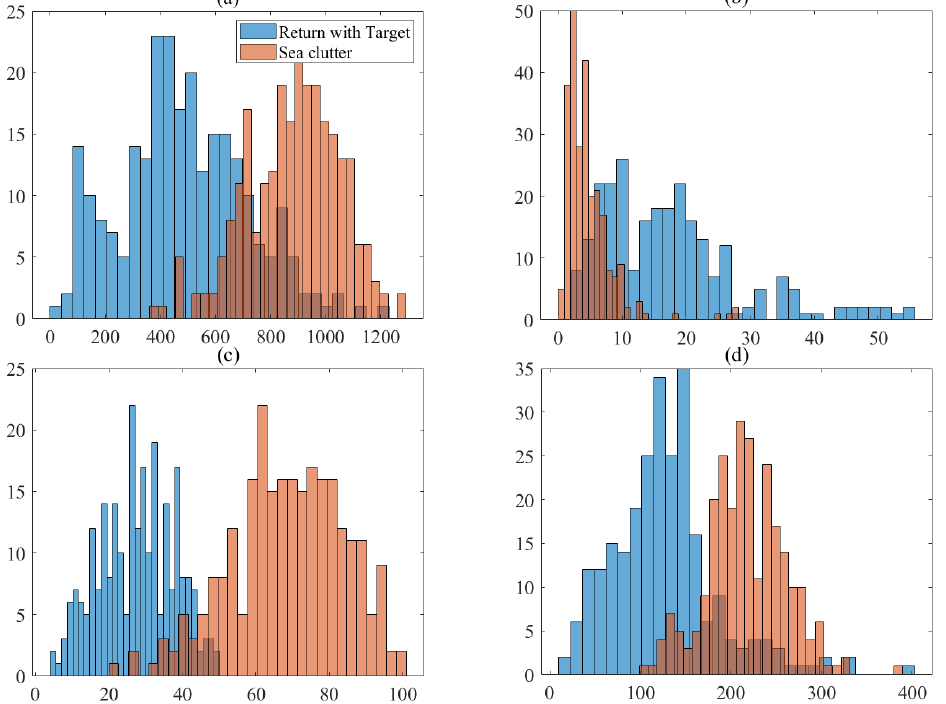
Figure 4. Histogram contrasts of the four features between sea clutter and target returns of #320 data at the HH polarization. ( a ) ξ 1 . ( b ) ξ 2 . ( c ) ξ 3 . ( d ) ξ 4